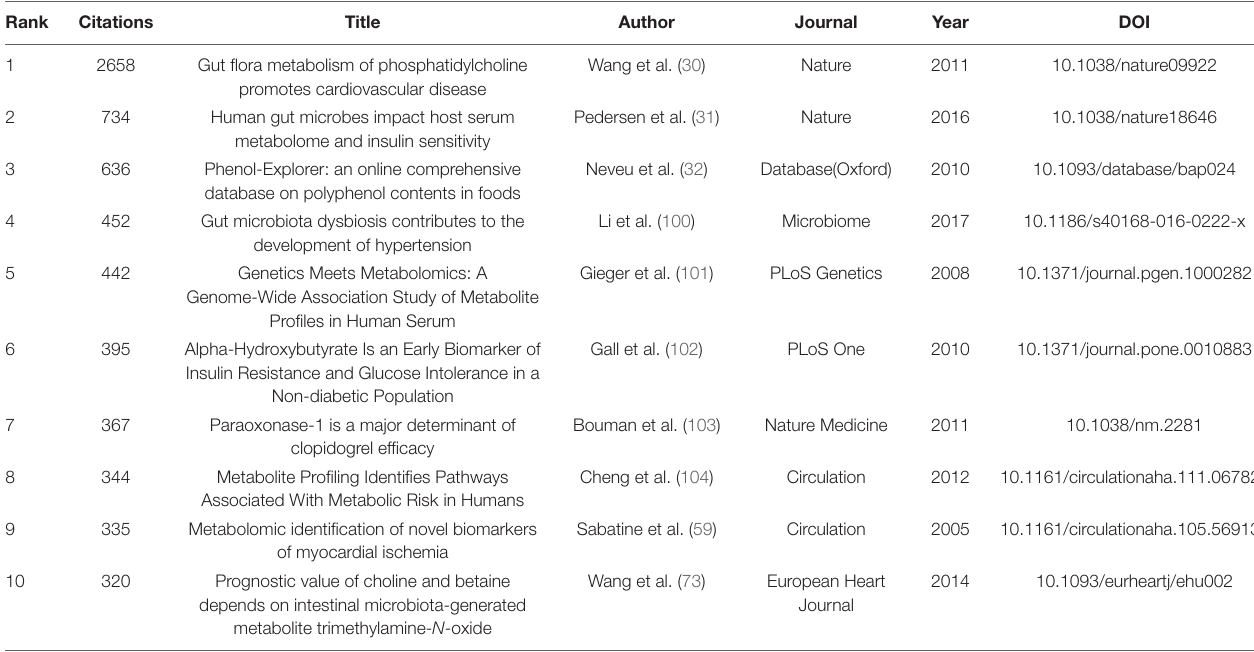
TABLE 5 | Top 10 cited